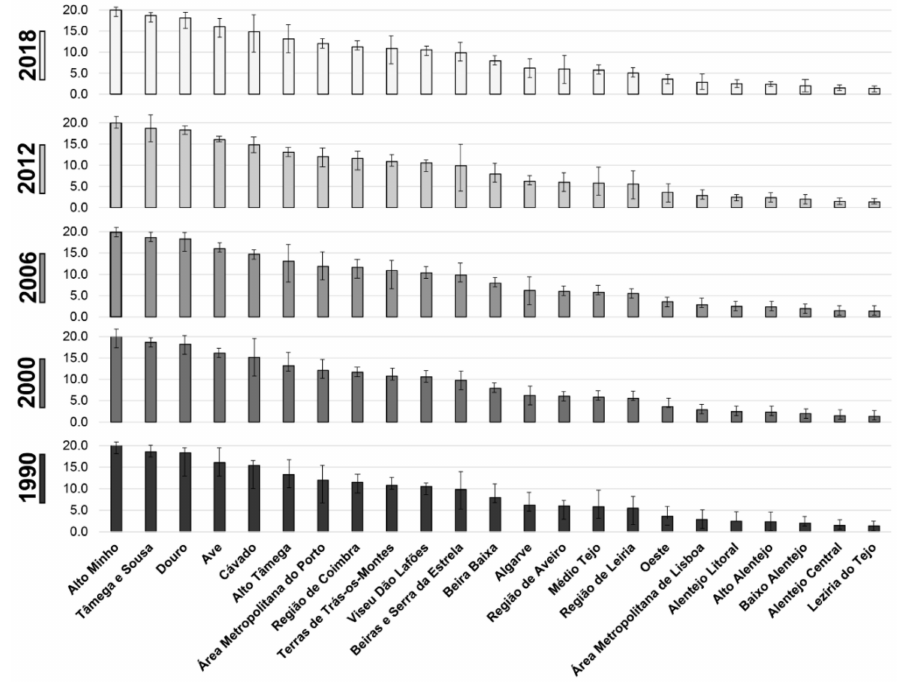
Figure 5. Mean ( ± SD) sediment retention (ton/ha) by NUTS III in mainland